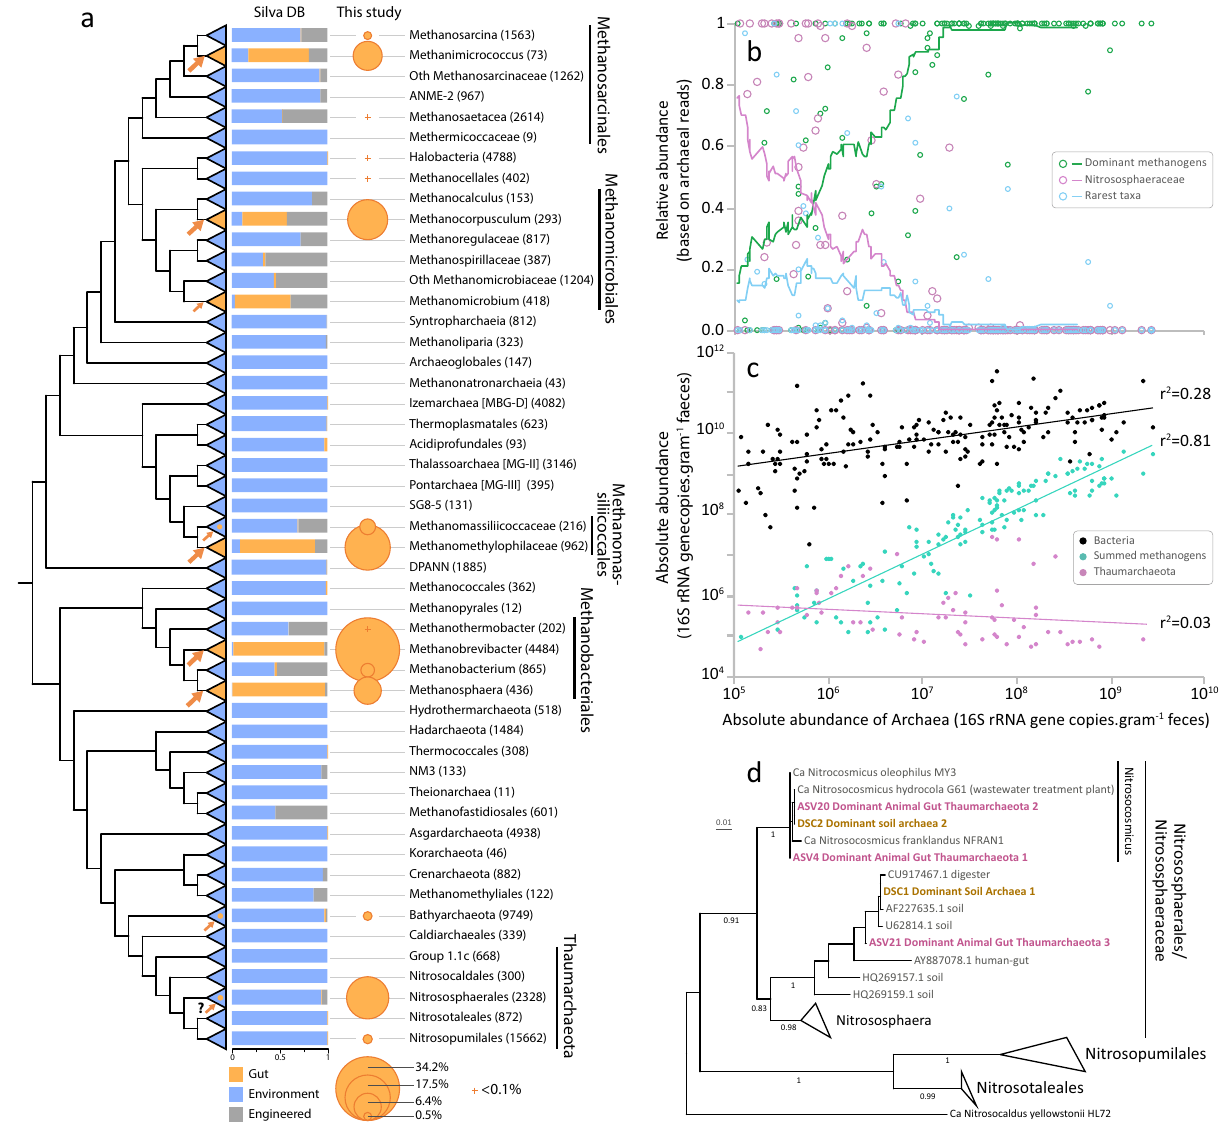
Fig. 2 Main archaeal lineages in the gut and proposed independent events of adaptation to the gut in the domain Archaea. a Distribution of archaeal 16S rRNA gene sequences in the gut and other environments based on sequences obtained from the Silva database and this study. The archaeal tree is based on Borrel et al. 112 enriched with DPANN lineages. Large arrows on the tree indicate fi ve main events of adaptation to the gut environment, small arrows indicate four other possible events of adaptation to the gut. Fully orange triangles indicate that gut adaptation likely occurred at the base of the lineage while blue triangles with an orange spot indicate that gut adaptation occurred within the lineage. The histogram shows the proportion of sequences (from the Silva database) of a given lineage present in either animal digestive tract ( “ Gut ” , orange), open natural environment ( “ Environment ” , blue) or built environment ( “ Engineered ” , grey). Orange circle surface area represents the percentage of reads attributed to each taxon in our study (gut-related samples only). b Proportion of archaea corresponding to the dominant methanogen lineages (green), Nitrososphaeraceae (purple) and rarest taxa (light blue) in samples, based on amplicon sequencing (Miseq) with archaea-speci fi c primers, according to absolute abundance of archaea in the sample (qPCR). Dots indicate the relative abundance of these three groups of archaea in each sample. Coloured lines indicate the moving averages of the relative abundance of these three groups on a subset size of 25 samples. The dominant methanogen lineages category contains Methanobrevibacter , Methanosphaera , “ Ca . Methanomethylophilaceae ” , Methanocorpusculum , Methanimicrococcus . The rarest taxa category contains Methanobacterium , Methanothermobacter , Methanomassiliicoccaceae , Methanosarcina , Methanoregulaceae , Methanospirillaceae , Methanosaeta , Methanocellales , Nitrosopumilaceae , Nitrosotaleaceae , Bathyarchaeota , Halobacteriales . c Correlation between the absolute abundance (16S rRNA copies/gram of faeces) of archaea and bacteria (black), summed methanogen lineages ( Methanobacteriales , Methanomassiliicoccales , Methanomicrobiales , Methanimicrococcus ; green) and Thaumarchaeota (purple), all determined by qPCR using lineage-speci fi c primers. Same samples ( n = 176) are plotted in panels b) and c) and correspond to those with ampli fi ed archaea in deep sequencing (Miseq). The scale of the absolute abundance of archaea is the same than in b , c . d Phylogenetic position of dominant gut Thaumarchaeota (this study, ASV4, ASV20 and ASV21, purple, bold) and dominant soil archaea 44 (DSC1 and DSC2, brown, bold). ASV4/ ASV20 are practically identical to DSC2 representative sequence (only 1 indel in a 4/5Gs homopolymer region, which may be due to a 454-sequencing error in DSC2 129 ). ASV21 shares 99.2% identity with the DSC1 representative